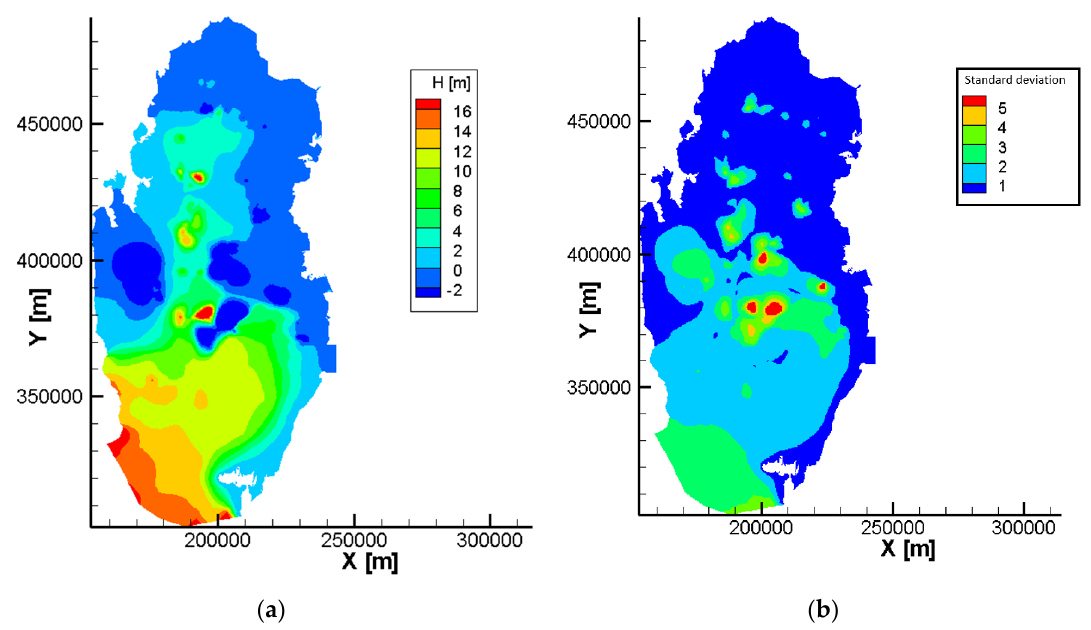
Figure 7. Local mean piezometric heads (m) ( a ). Standard deviation of piezometric heads (m) ( b